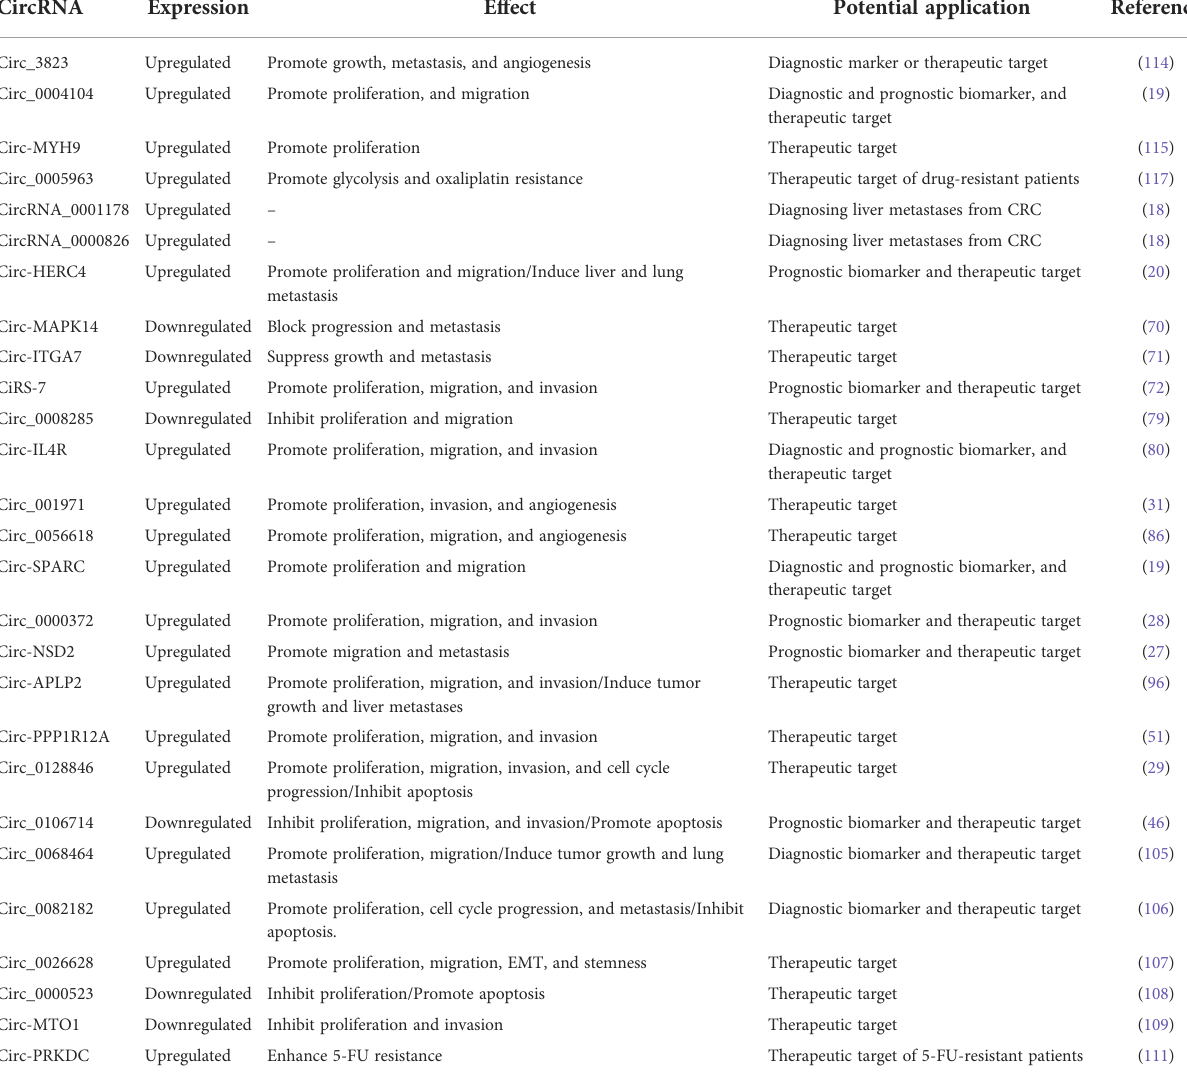
TABLE 1 Potential clinical application value of circRNAs in